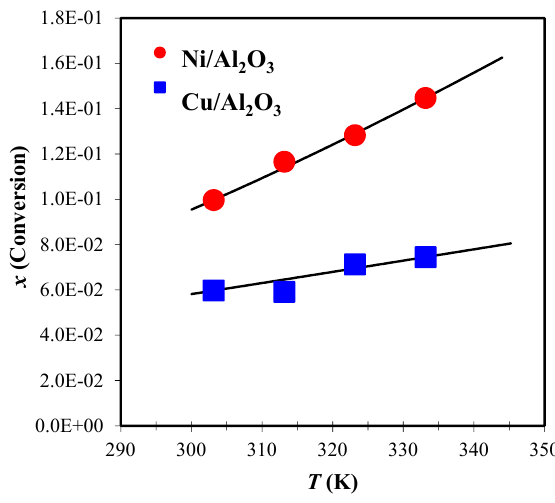
Figure 7. Conversion fraction at 24 h as a function of the temperature for a parallel-plate reactor for both metals supported on alumina powder adhered to the